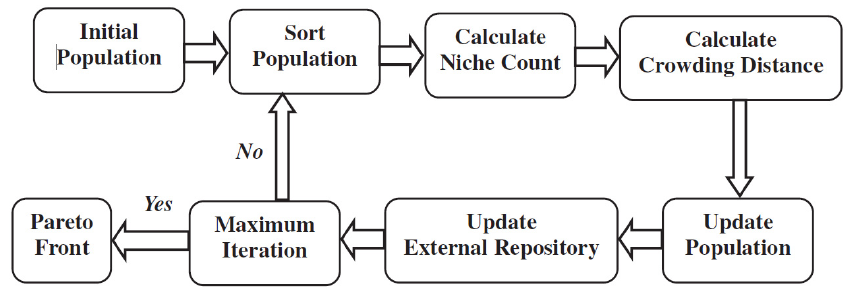
Figure 16. Flow chart of modified particle swarm optimization (PSO) algorithm.